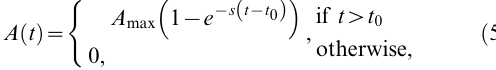
Figure S1 Kinetics of autologous Nab responses, plas- ma viral load and CD4 + T lymphocyte counts. Autologous plasma Nab titers against the respective T/F Envs for subjects CH40, CH77 and CH58, as measured by TZM assay and expressed as reciprocal IC 50 s, are shown in bold lines. Each value is the average of four independent experiments, performed in duplicate. The minimal plasma dilution used in the assay was 1:20, and for this plot Nab titers of , 1:20 are denoted as zero. Each subject’s plasma viral load is color-coded and represented by dashed lines; the CD4 + T lymphocyte count is represented in black with the scale to the right. Figure S2 Replicative fitness of Nab escape mutants. A. Replication kinetics of CH40 T/F, 6 mo, and 6 mo-Nab IMCs cultured in parallel. Virus stocks were generated on CD4 + T cells and equal M.O.I.s were inoculated onto parallel cultures of CD4 + T cells from two seronegative donors. Viral p24 antigen was measured every 2 days. B. Replication kinetics of CH40 IMCs grown in direct competition. Equal quantities of viruses derived from CH40 6 mo IMC and CH40 6 mo-Nab IMC were co- cultured in the same CD4 + T lymphocytes. 50 ul of supernatant was removed every two days and assayed for viral growth by p24 antigen ELISA and tested for relative proportions by PASS. Replication kinetics of CH77 (C) and CH58 (D) T/F, 6 mo, and 6 mo-Nab IMCs. Results represent mean ( + / 2 SD) of three independently performed experiments. Figure S3 Model of HIV infection and Nab escape in acute infection. In this model, wild-type (WT) or T/F virus, V wt , is produced from infected cells, I wt , at rate p wt and is cleared at rate c v per virion. The virus infects uninfected target cells, T , at rate 1 { a